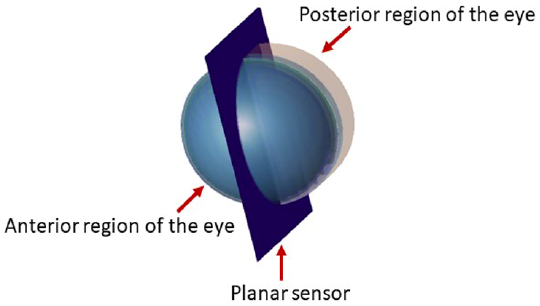
Figure 2. The placement of the planar sensor bisecting the model in the sagittal plane.